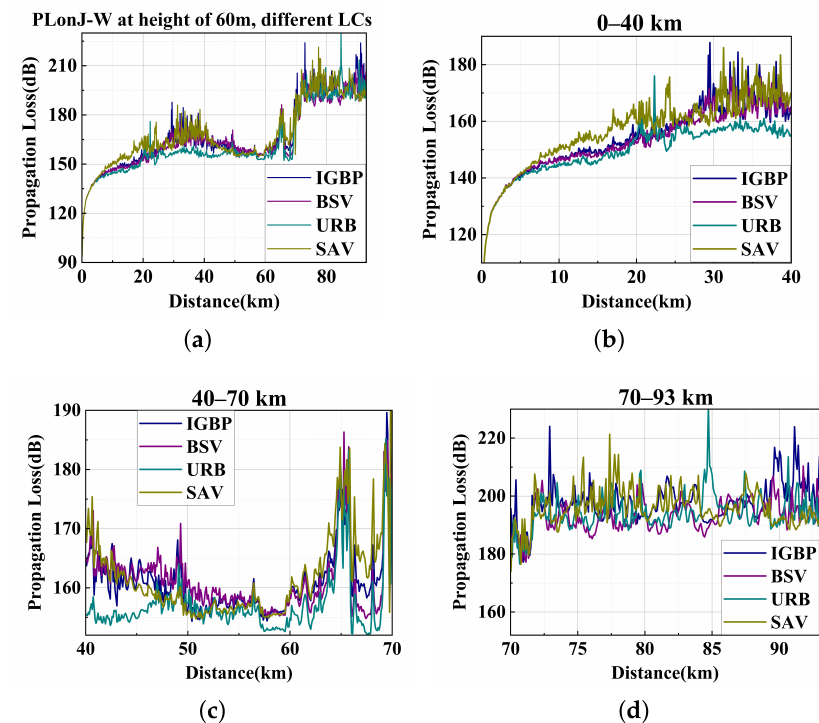
Figure 25. The Propagation loss using the improved TWPE at a height of 60 m using different land covers, on Jiaxing–Wuxi. ( a ) PL on J–W at different LCs at at antenna height of 60 m. ( b ) PL on J–W at range of 0–40 km at different LCs. ( c ) PL on J–W at a range of 40–70 km at different LCs. ( d ) PL on J–W at a range of 70–93 km at different